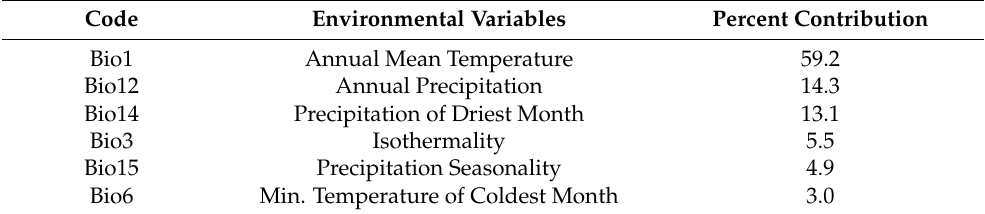
Table 1. MaxEnt results of the percentage contribution and permutation importance of Bioclimatic variables for the selected model developed for O. robiniae .